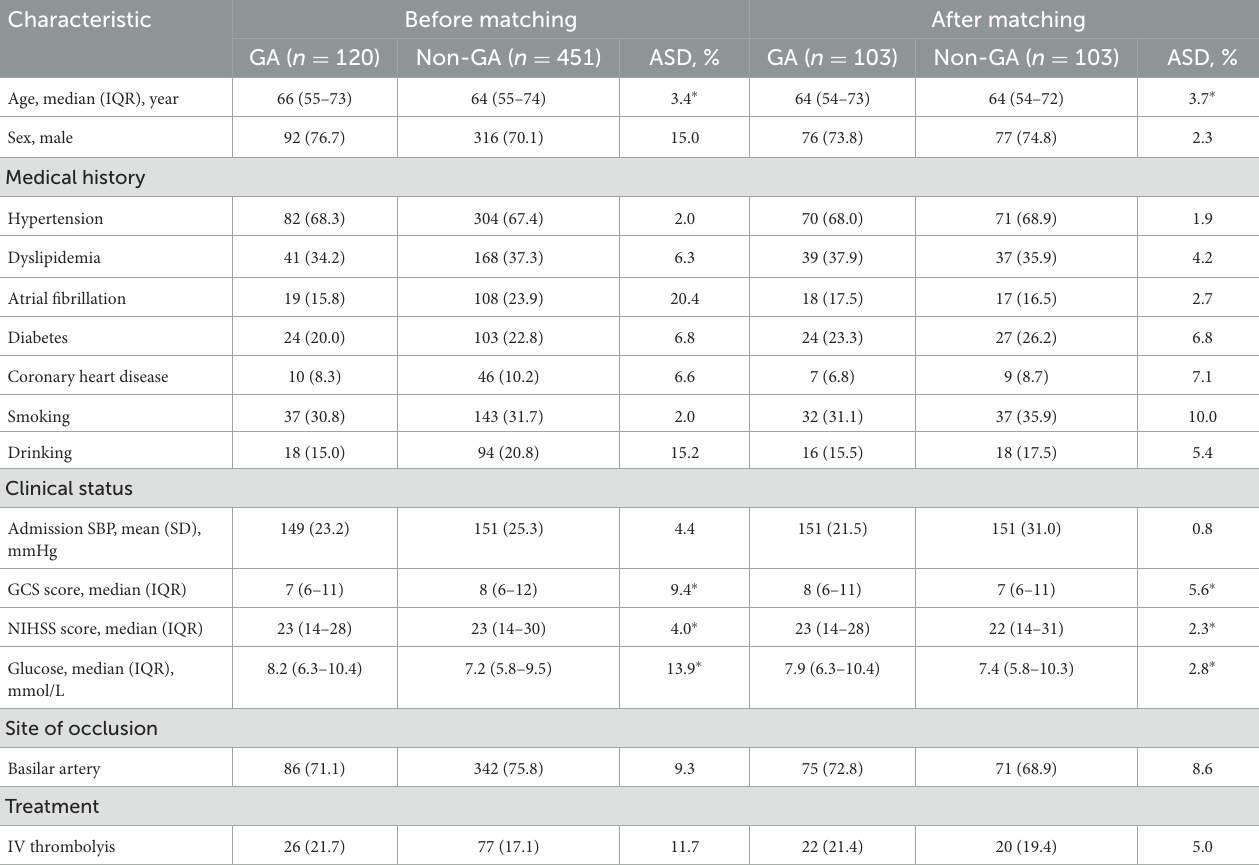
TABLE 1 Clinical characteristics according to anesthetic approach in VBAO patients admitted for thrombectomy before and after propensity score matching. Characteristic Before matching After matching Non-GA ( n =